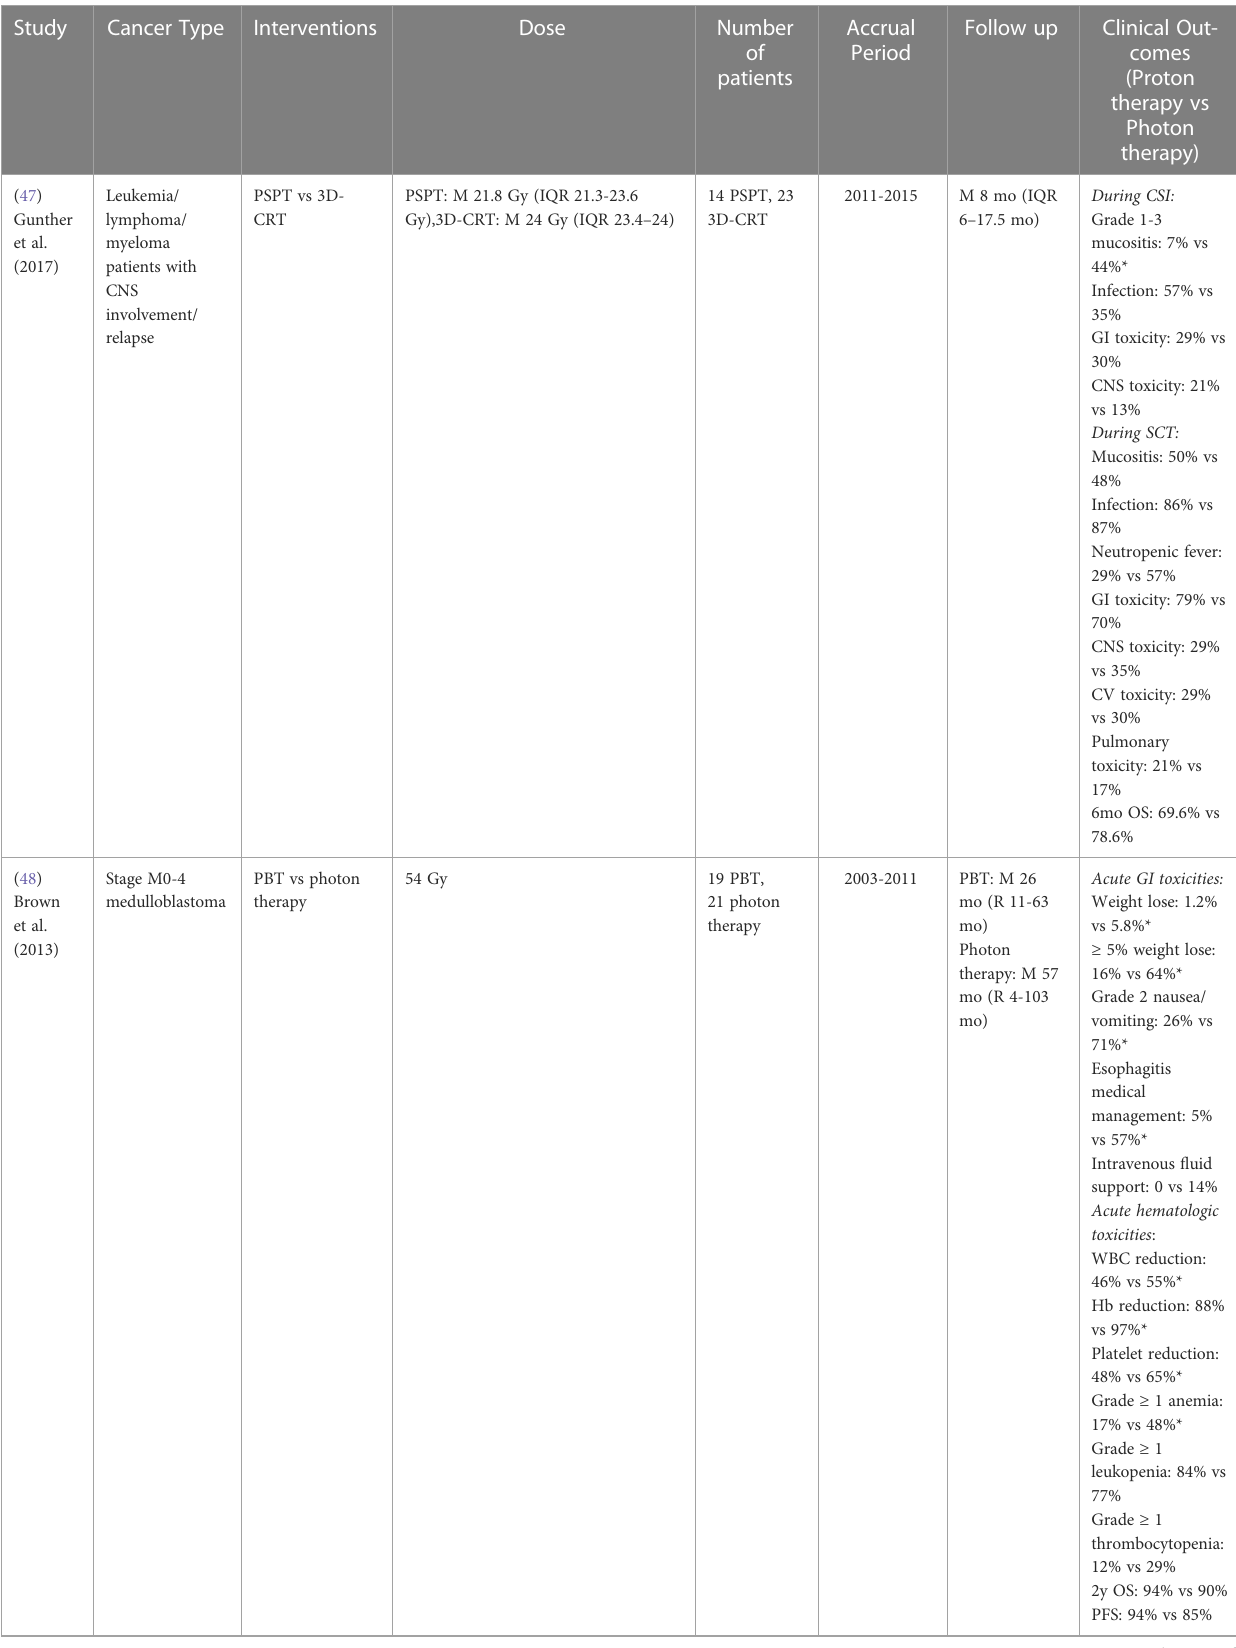
TABLE 6 Non-randomized clinical studies of proton versus photon radiation therapy – adult CNS